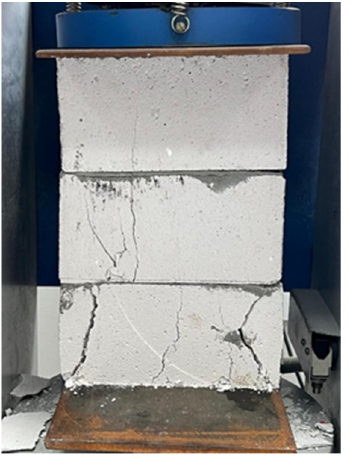
Figure 4. Triplet setup of the AAC blocks after the compressive strength test. Table 1. Compressive strength results of the AAC blocks.